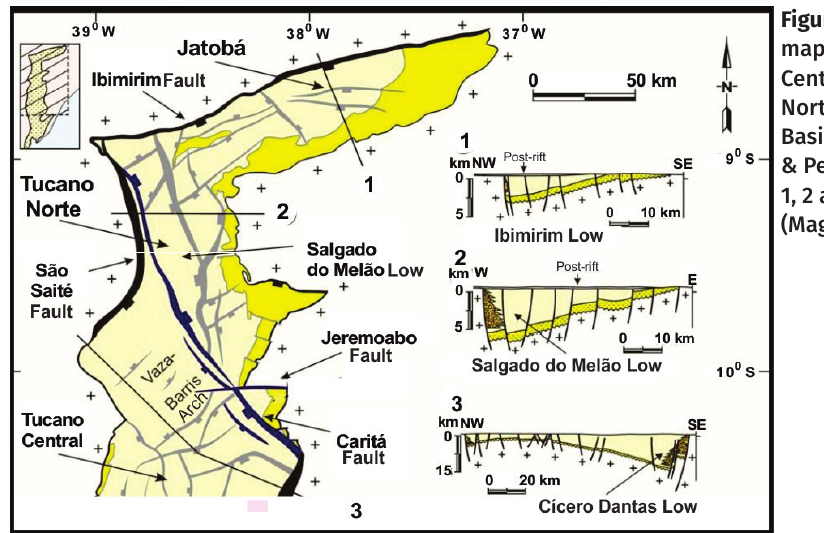
Figure 10. Simplified tectonic map of part of the Tucano Central Sub-basin, Tucano Norte Sub-basin and Jatobá Basin (modified from Aragão & Peraro 1994); sections 1, 2 and 3 are also shown (Magnavita